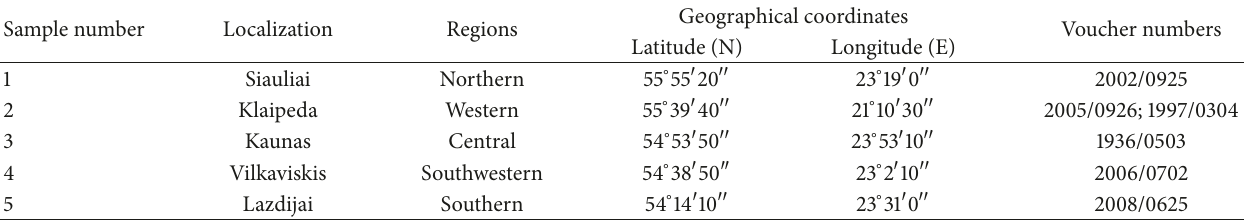
Table 1: Geographical coordinates of the Ginkgo biloba accessions that were harvested in Lithuania.